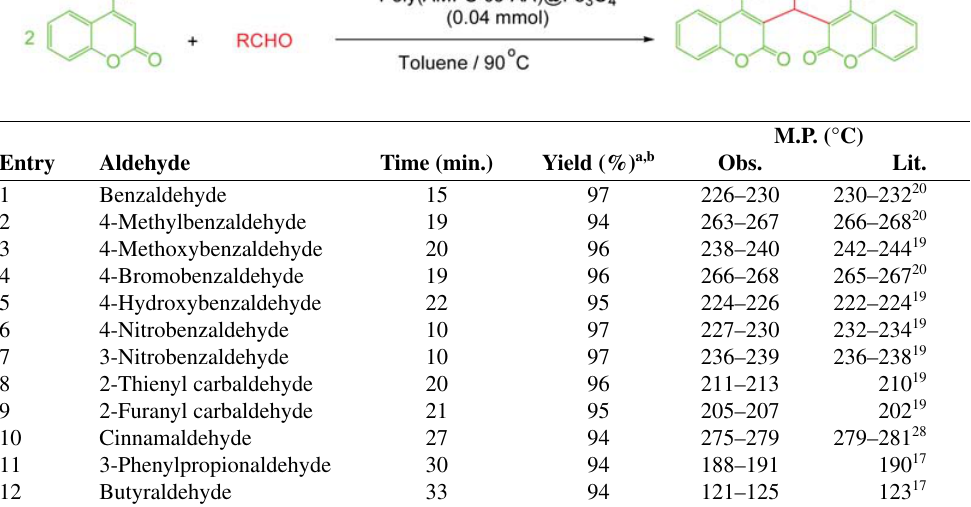
Table 1: Synthesis of biscoumarin derivatives catalyzed by poly(AMPS- co -AA) @ Fe